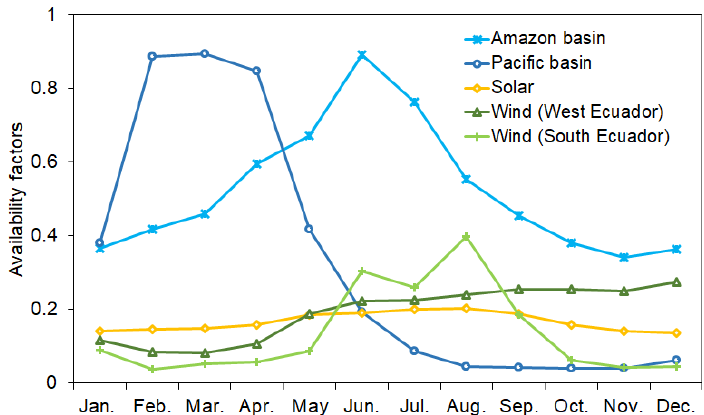
Figure 6. Monthly normalized availability factors for hydropower plants in the Amazon and Pacific basins, wind parks in Western and Southern Ecuador, and photovoltaics